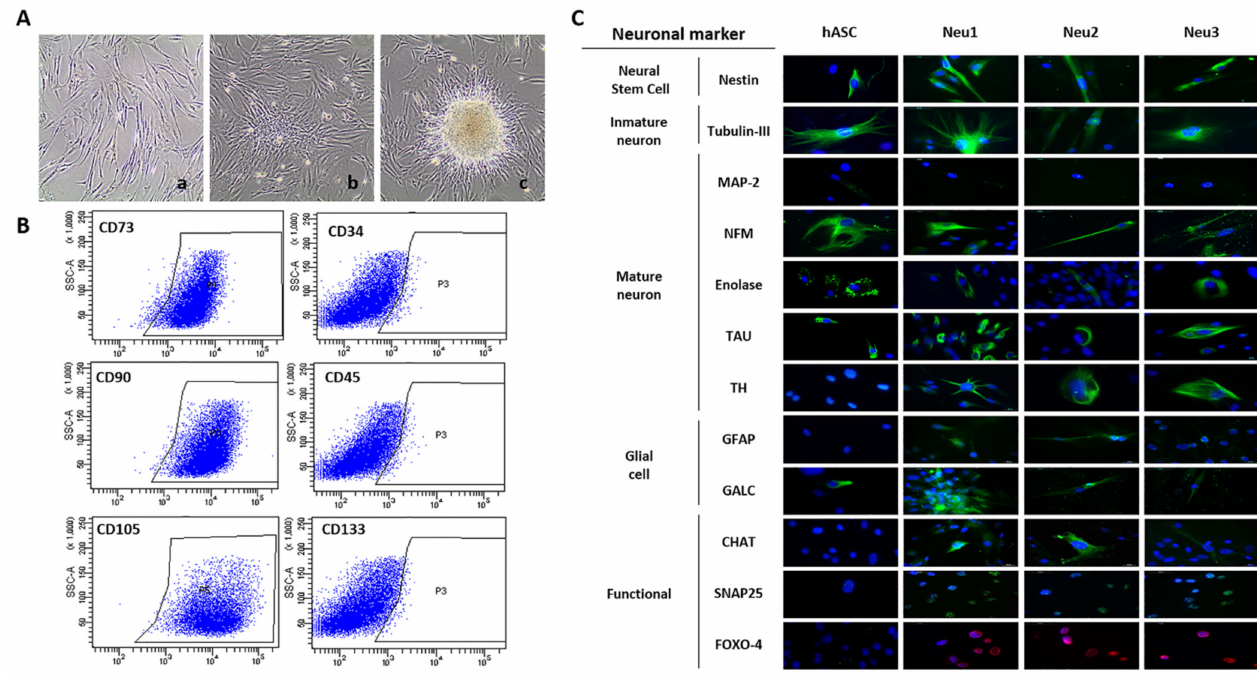
Figure 1. Isolation, characterization, and differentiation of hASCs. ( A ) The cells grow as a monolayer adhering to the surface of the flask and form colonies on ( a ) day 7, ( b ) day 14, and ( c ) day 21. ( B ) Immunophenotypic characterization of hASCs by FACScan analysis showing mesenchymal and hematopoietic surface markers. Approximately 99% of cells were positive for mesenchymal markers (CD73: 98.1%, CD105: 99.9%, and CD90: 99.6%), and 98.5% were negative for hematopoietic markers (CD45: 2.4%, CD34: 2.4%, and CD133: 1.7%), representing a typical mesenchymal-like immunophenotype (all mAbs from BD Biosciences). ( C ) Representative immunofluorescence analysis of markers in hASCs. Markers of neural stem cells, immature and mature neurons, glial cells, and functional markers (green) were analyzed in hASCs control, hASCs exposed to Neu1 (21 days), Neu2 (15 days), and Neu3 (10 days) media. Nuclei were stained with Hoechst solution